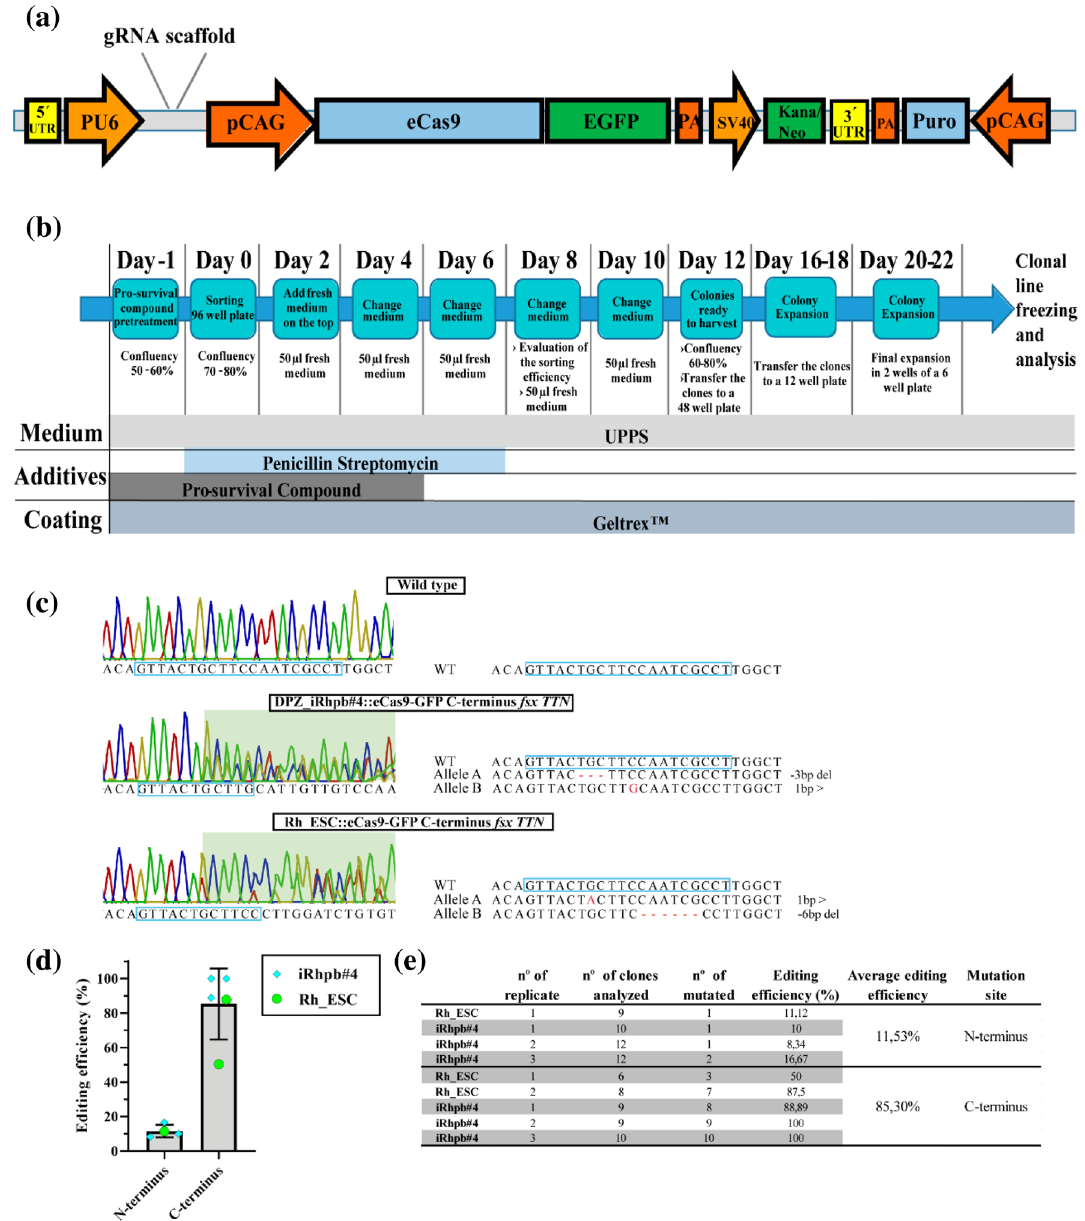
Figure 6. Genome editing of rhesus macaque pluripotent stem cells using the piggyBac system. ( a ) Schematic representation of the piggyBac vector used for CRISPR/Cas9 expression, pTT-PB-pCAG-eCas9-GFP-U6-gRNA- Neo . Three independent expression units are contained in the piggyBac construct. (1) U6 promoter regulating the expression of tRNA-gRNA, (2) CAG promoter-driven expression of eCas9-eGFP fusion transcript. A T2A sequence separates both coding sequences. (3) SV40 promoter driving the expression of the Kanamycin/ Neomycin resistance gene. ( b ) Single-cell cloning work-flow. ( c ) Proof of concept mutation analysis of monoclonal lines by PCR amplification of the C-terminal TTN locus and Sanger sequencing. The figure shows the representative sequence analysis of two different clones, one of iRhpb#4 and the other Rh_ESC. Left figures show chromatograms of the wildtype versus the mutated lines. The mutation site is indicated by the appearance of doublet peaks and the gRNA binding site by a green rectangle. ( d , e ) Genome editing efficiency of the TTN regions encoding the N- and C-termini, respectively. Four (N-terminus) and five (C-terminus) independent experiments were performed. All transfections led to mutated clones with an efficiency ranging from 8.3 to 100%. Overall, mutation efficiency was 11.53% for the N-terminual gRNA and 85.3% for the C-terminual gRNA. ( d ) Graph representing editing efficiency (Mean ± SD). ( e ) Breakdown of the different experiments